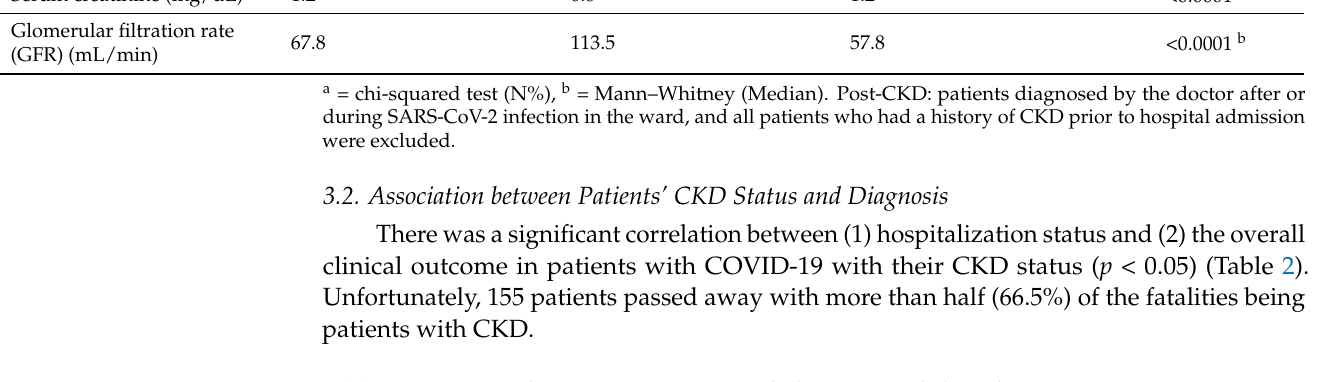
Table 2. Association between CKD status with diagnosis and clinical